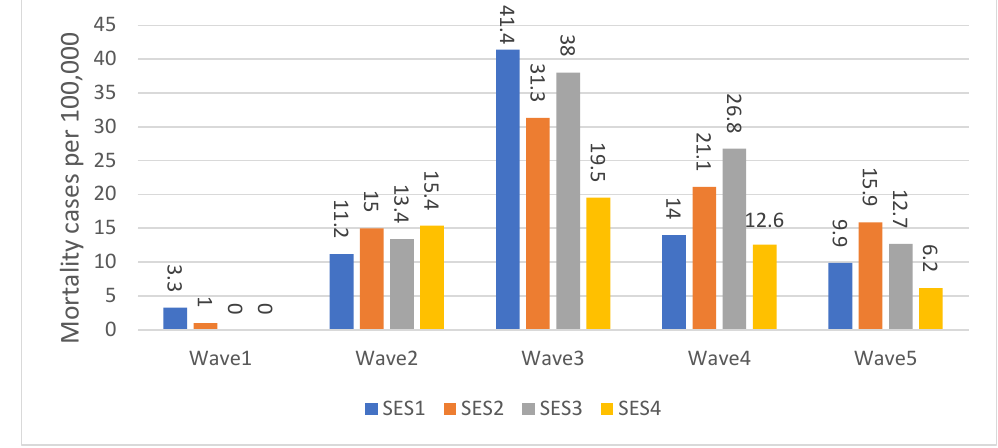
Figure 3. Age-Adjusted death cases by SES and Waves per 100,000 population.